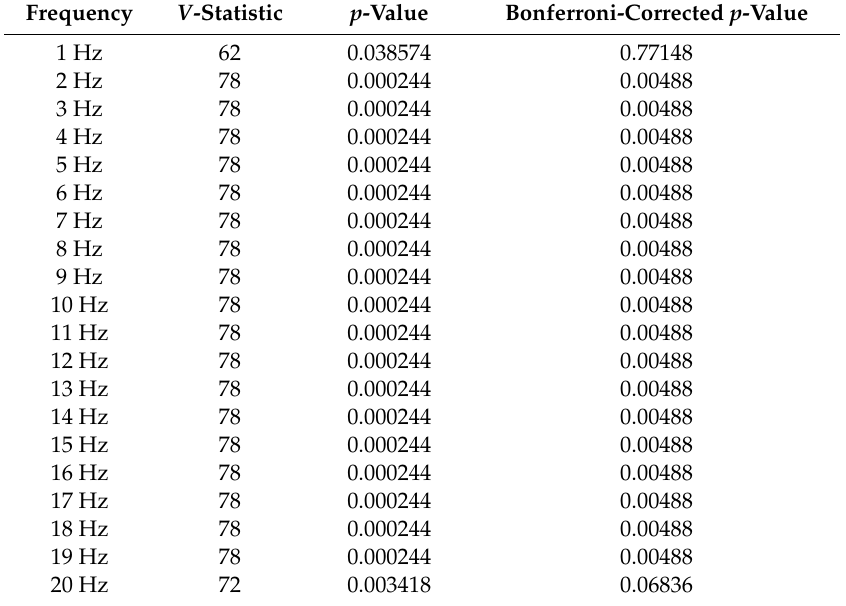
Table 3. Results of one-sample Wilcoxon signed-rank tests ( V -statistic, p -value, and Bonferroni-corrected p -value) on the co-occurrence between utterance and physical motion at each